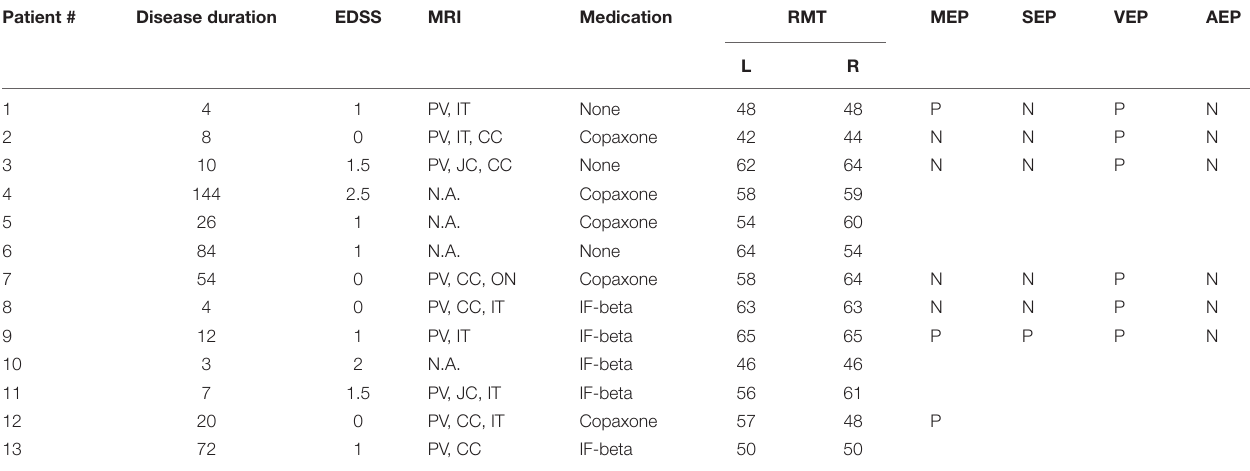
TABLE 1 | Patient